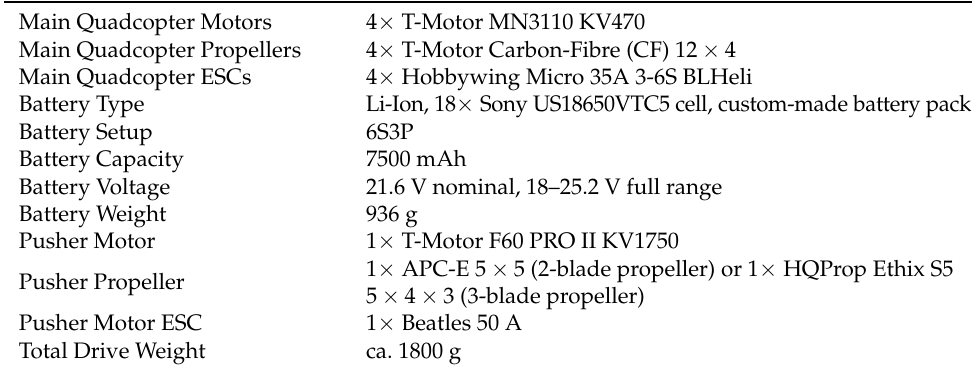
Table 1. The final electric propulsion setup.